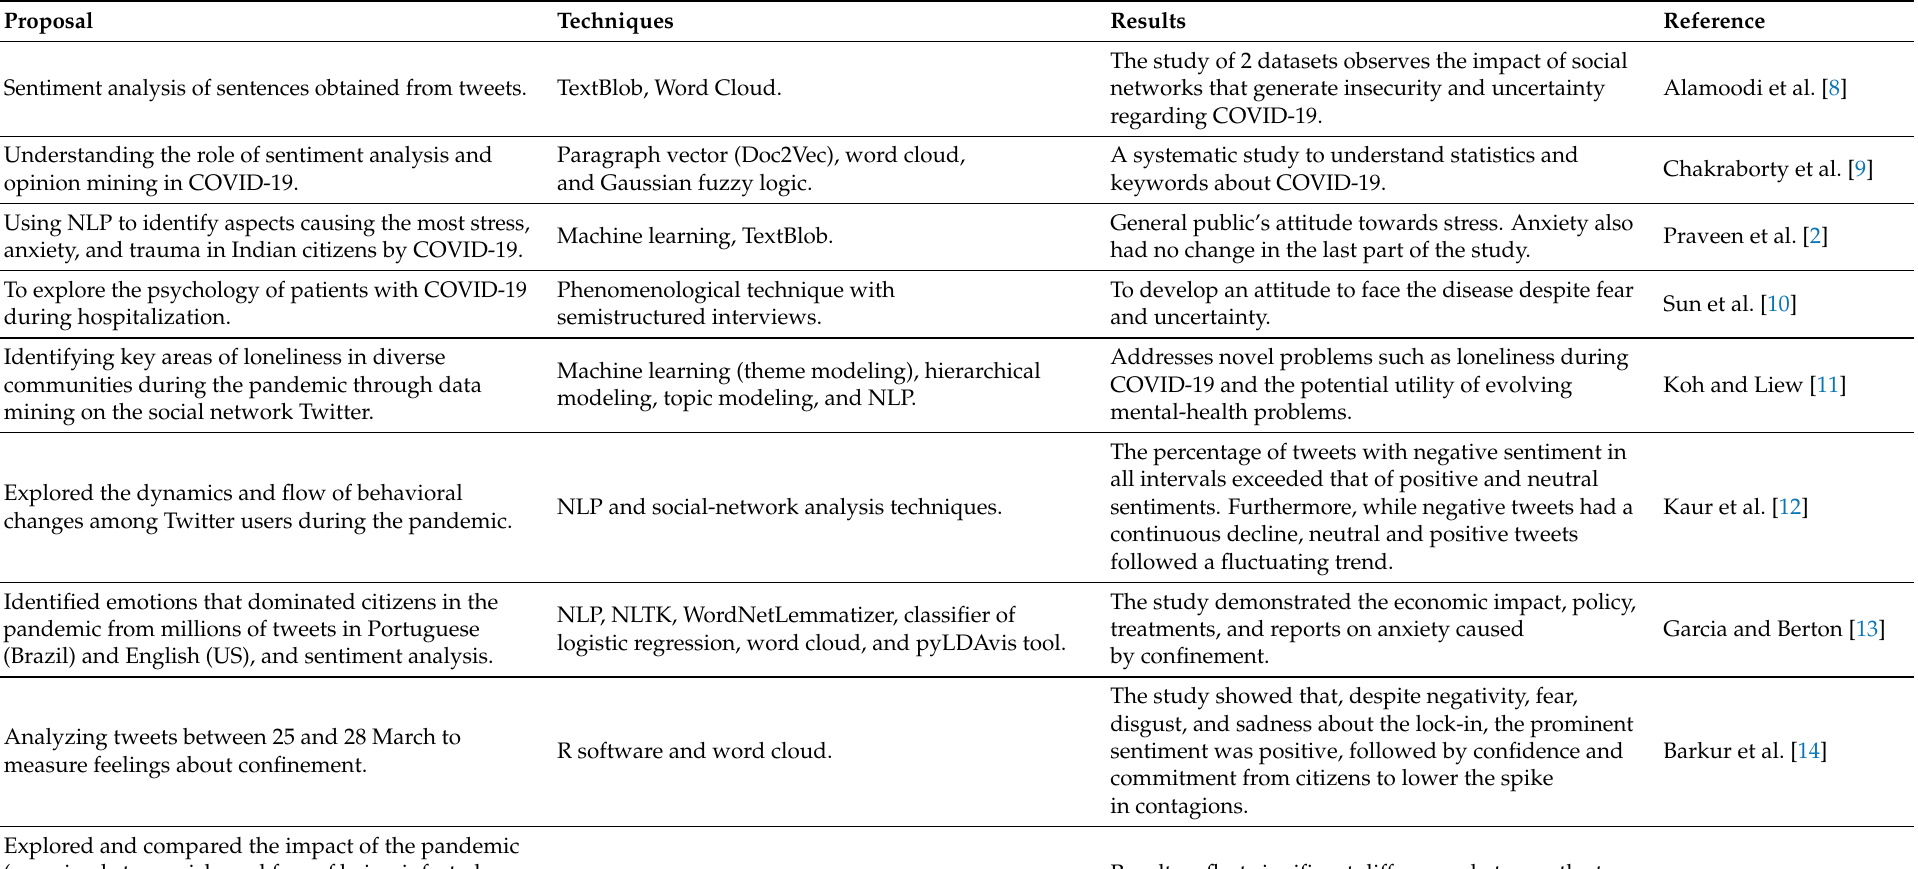
Table 1. Representative publications that addressed the COVID-19 issue from a computational